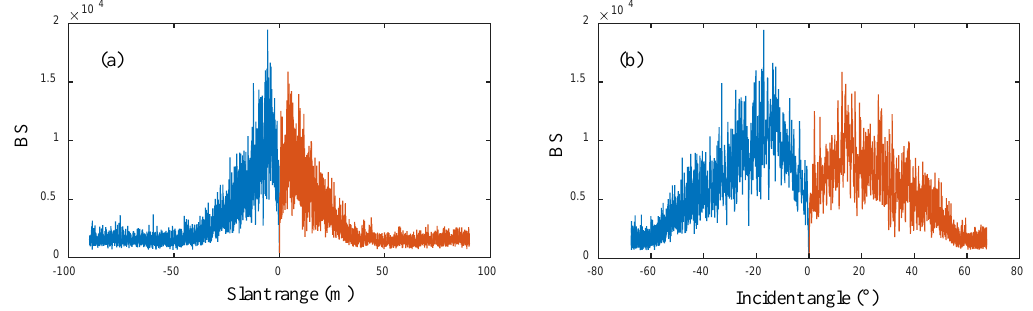
Figure 6. ( a ) Range–BS sequence; and ( b ) corresponding angle–BS sequence of a ping.